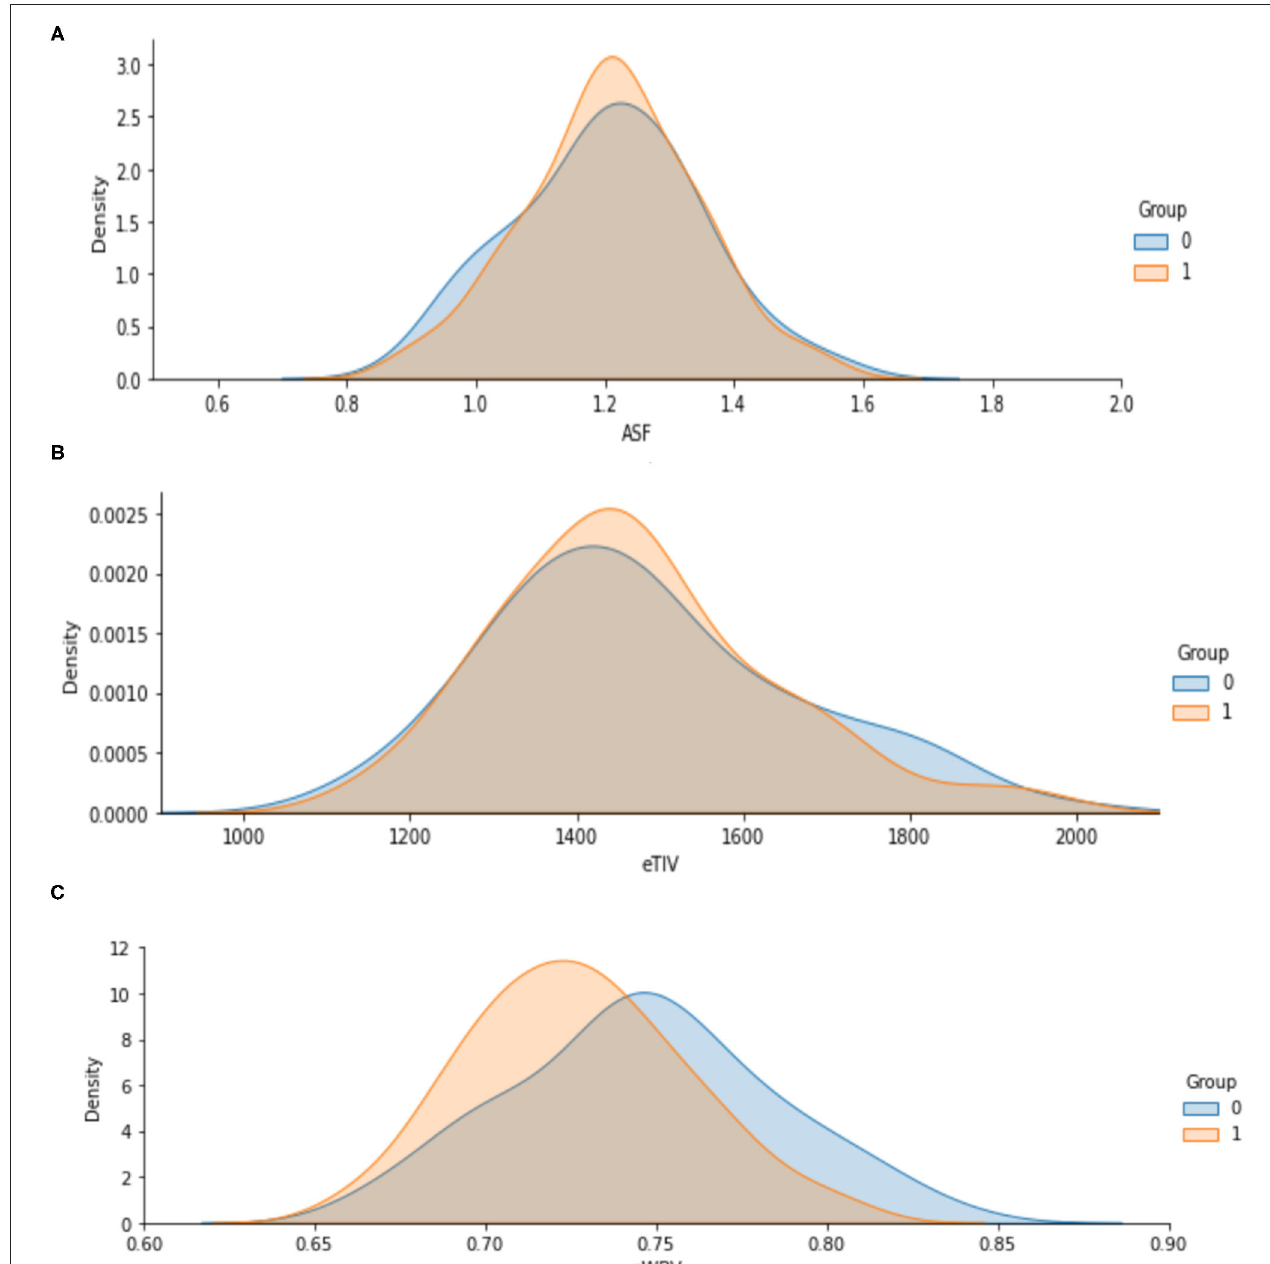
FIGURE 5 | (A–C) Analysis of ASF, eTIV and nWBV for Demented and Non-demented